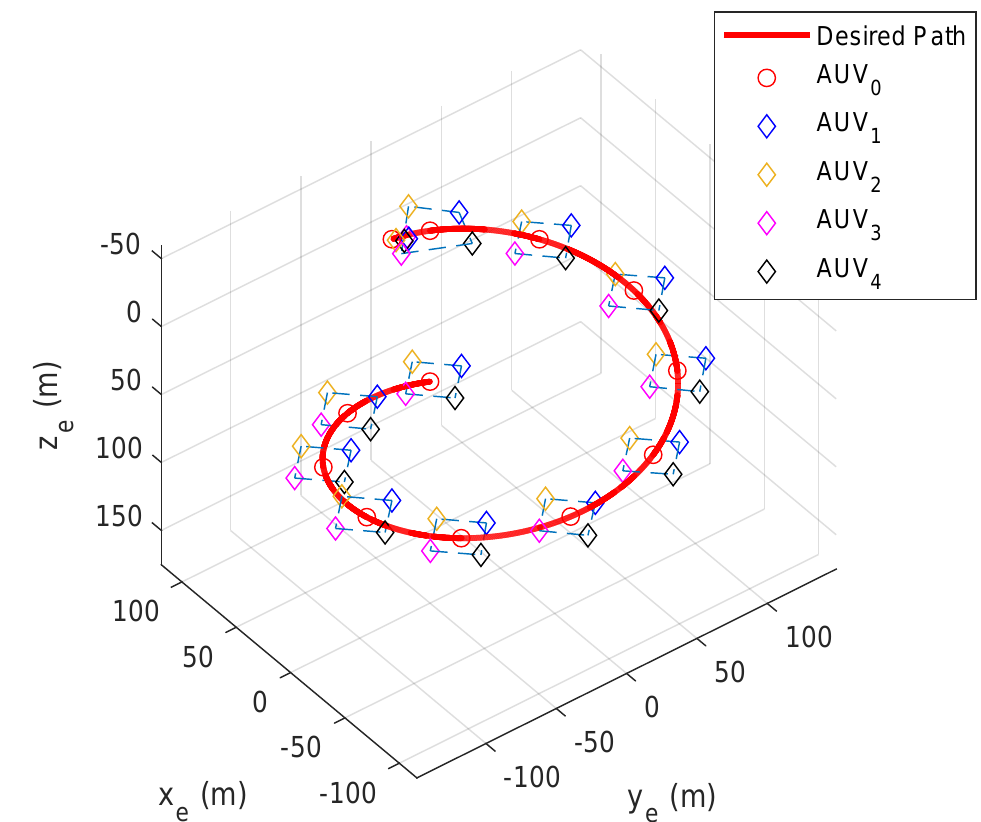
Figure 18. Trajectory of multi-AUV under alterable communication topology with